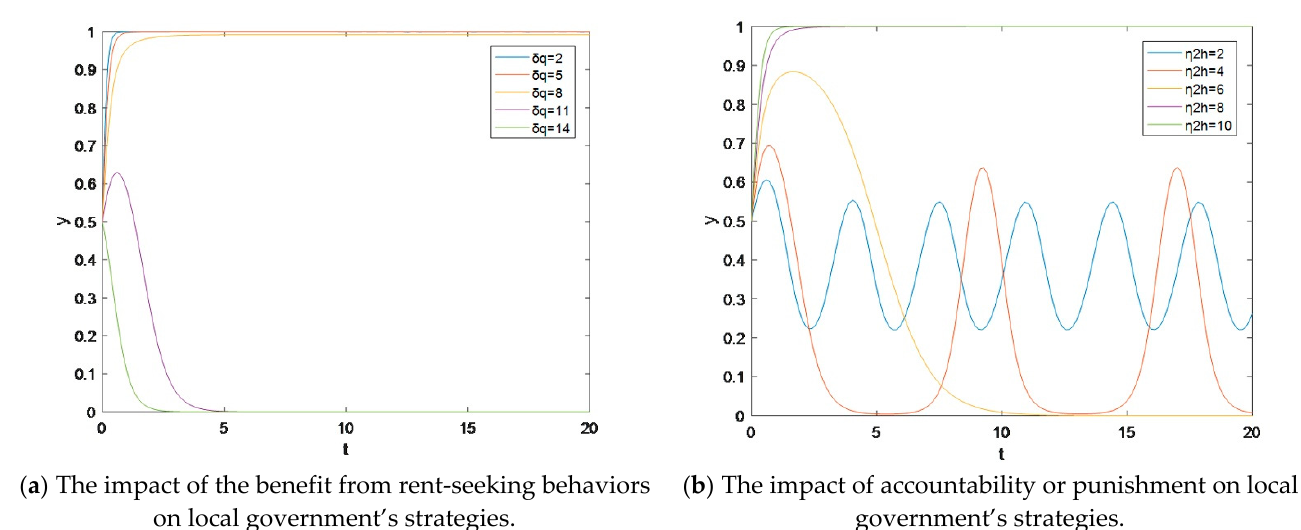
Figure 14. The impact of additional confirmation costs and long - term benefits on local government’s strategies.